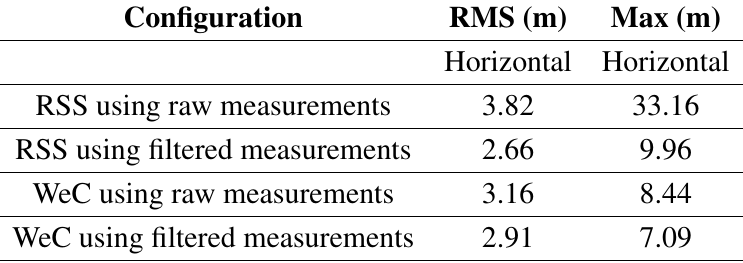
Table 2. Pseudolite-only statistical position error parameters: RMS and maximum errors for the horizontal